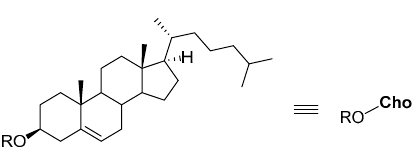
Figure 2. Schematic representation of cholesterol-based molecules throughout the manuscript.